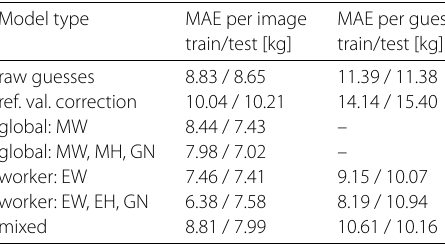
Table 2 Correction models for weight estimation